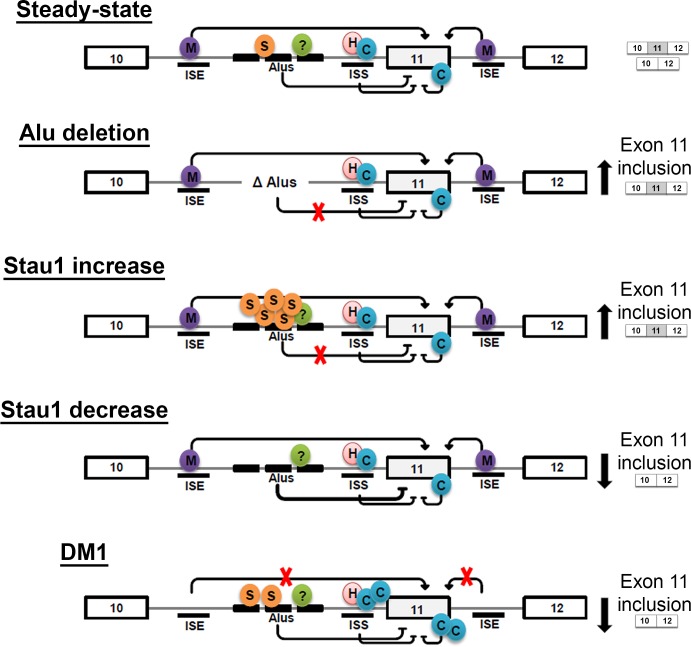
Proposed model of how Stau1 may contribute to INSR exon 11 alternative splicing.At steady-state, Stau1’s binding to Alu elements participates in the integration of several regulatory mechanisms towards establishing the level of utilisation of exon 11. Introns are denoted as grey lines and exons as large boxes. The splicing factors MBNL1 (M), CUGBP1 (C), hnRNP H (H), and Stau1 (S) are depicted binding to various known cis-regulatory elements (i.e. intronic splicing enhancer (ISE) and intronic splicing silencers (ISS)) and to the Alu elements (Alus). Complete deletion of the Alu elements results in increased exon 11 inclusion, suggesting they normally contribute towards a repressive influence on exon inclusion. Upon overexpression of Stau1, increased exon 11 inclusion is also observed, suggesting Stau1 somehow disrupts the repressive influence of the Alu elements (see Discussion for details). Upon knockdown of Stau1 expression, the full inhibitory effect of the Alu elements would be observed. In DM1, the combined effects of reduced MBNL1 levels increased CUGBP1 activity, and a moderate increase in Stau1 would result in decreased exon 11 inclusion.